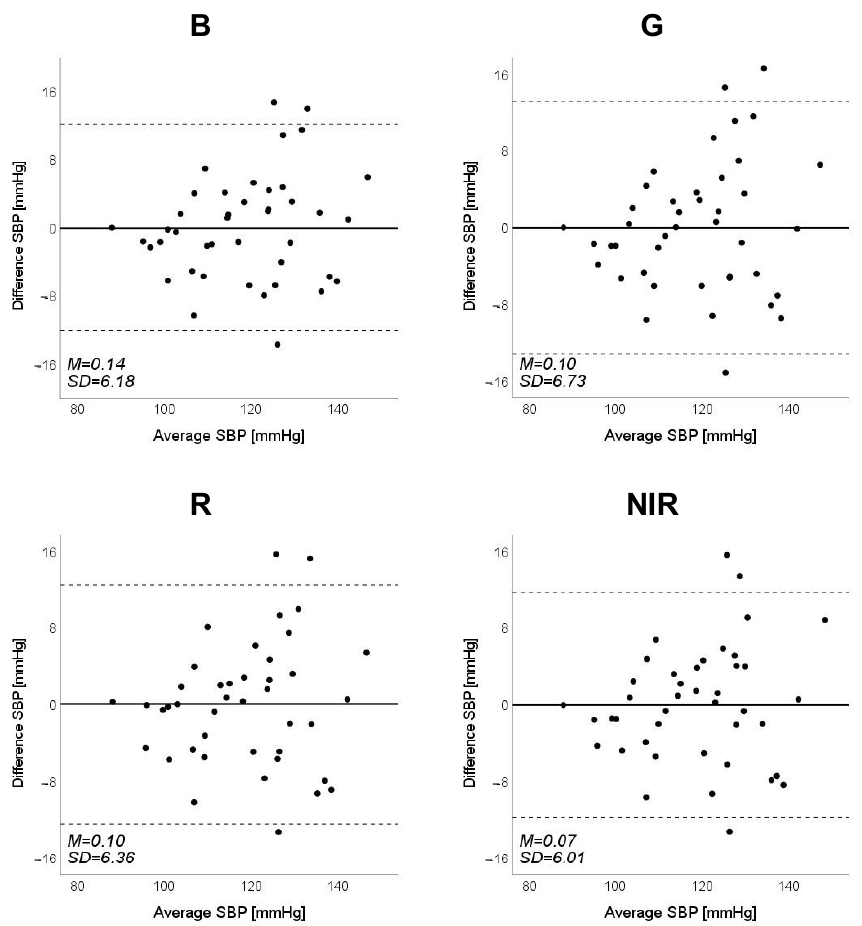
Figure 9. Bland–Altman plots of estimated systolic blood pressure (SBP) against those measured with a cuff sphygmomanometer (N = 42). From left to right, the light source is blue (B), green (G), red (R), and near-infrared (NIR). The solid line and the dashed lines on each plot represent fixed bias (M) and M ± 1.96 standard deviation range, respectively.